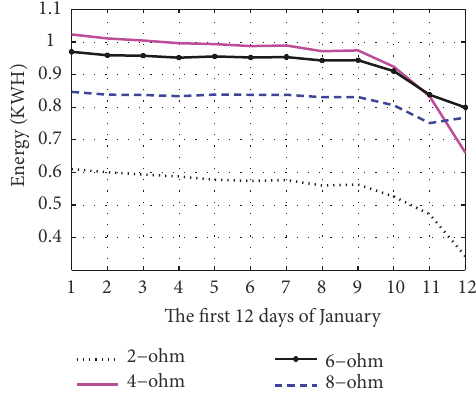
Figure 18: Variation in daily energy output of Kyocera 200GT PV module for the first 12 days of January under different electric